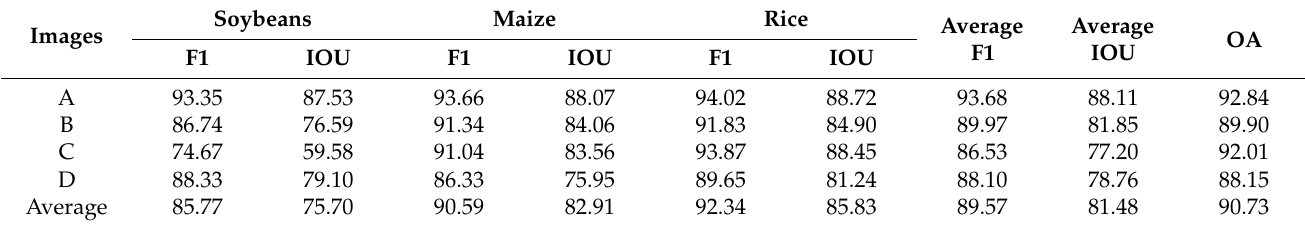
Table 1. The classification accuracy of crop classification, based on the OCBDL. (%).